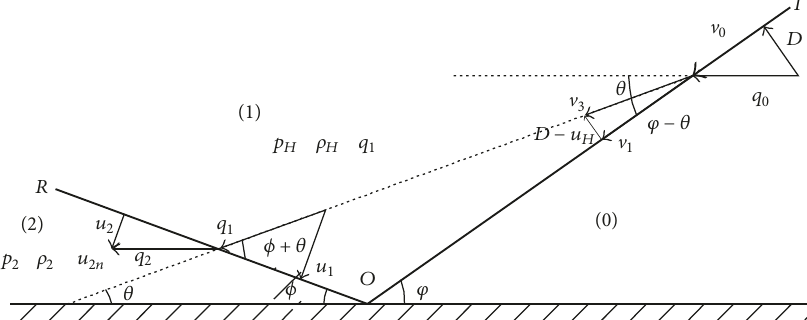
Figure 2: Detonation wave oblique reflection map in the coordinate system. (0), initial state; ( 1 ), stable detonation state; ( 2 ), oblique reflection state.